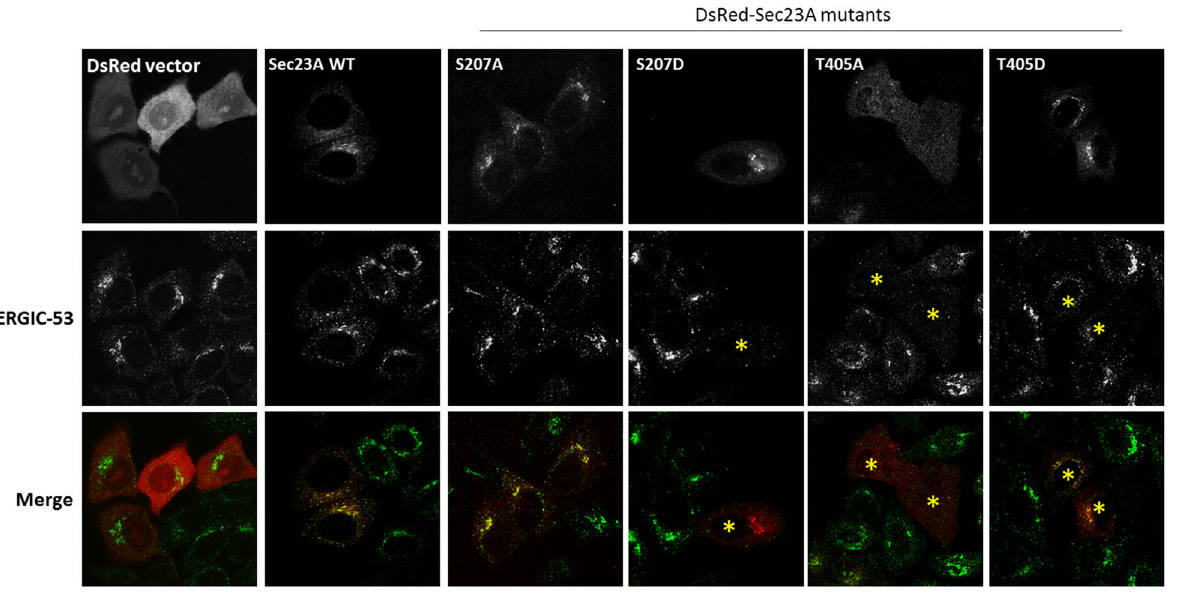
Fig. 7 Expression of the Sec23A mutant compromised the integrity of ERGIC. Various indicated Sec23A mutants in DsRed vector were transfected to HeLa cells and the status of ERGIC was investigated by staining with marker ERGIC-53. DsRed and ERGIC-53 signals are pseudo-colored in red and green , respectively, in the merge panel ( bottom